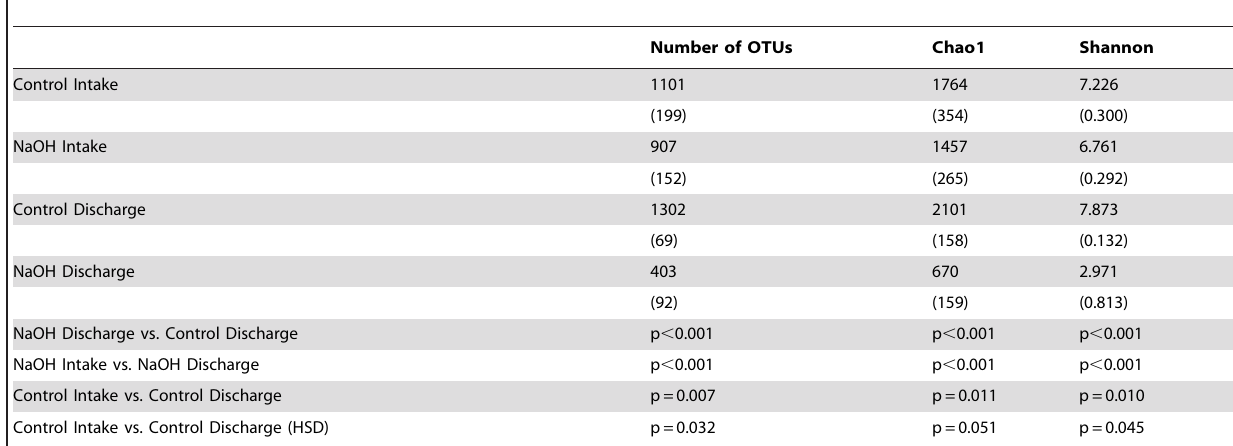
Table 2. Summary of averaged diversity measurements for each treatment group rarefied at 10,918